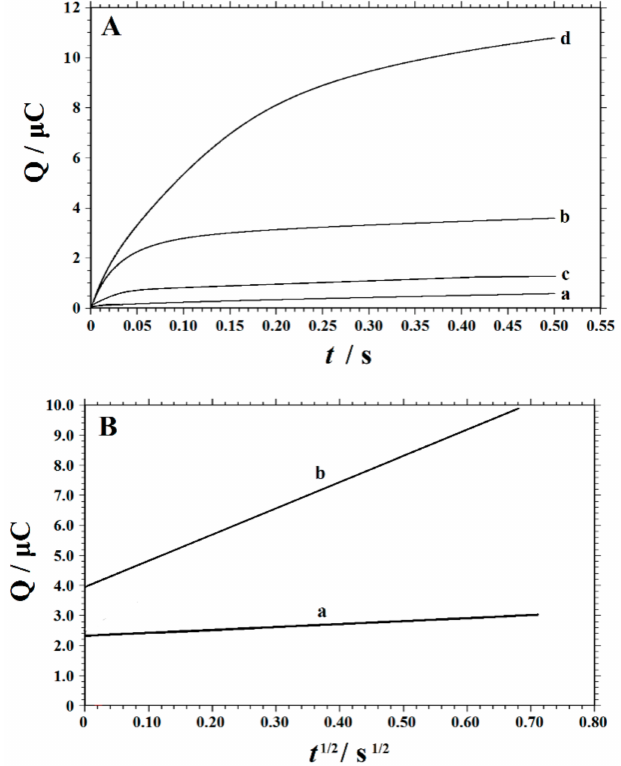
Figure 8. ( A ) Chronocoulometric curves in 0.1 M PBS (pH 2.2). Curve a and b for bare GCE in the absence and presence of 0.2 mM Trp, curve c and d for PVP-GR / GCE in the absence and presence of 0.2 mM Trp. ( B ) The plot of Q versus t 1 / 2 at GCE (a) and PVP-GR / GCE (b) after background charge